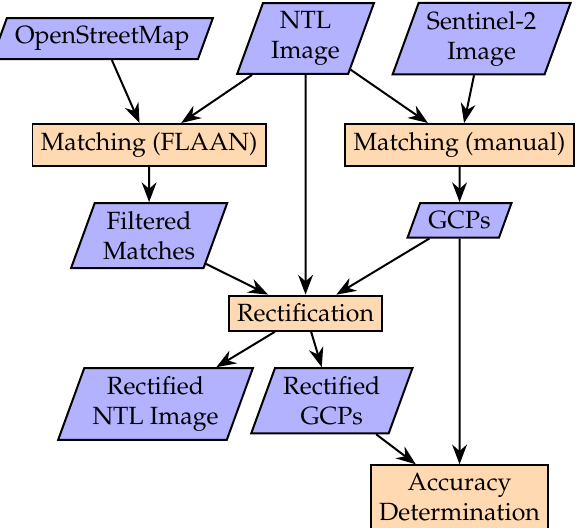
Figure 7. Evaluation approach used to determine the absolute accuracy of the georeferenced NTL images.